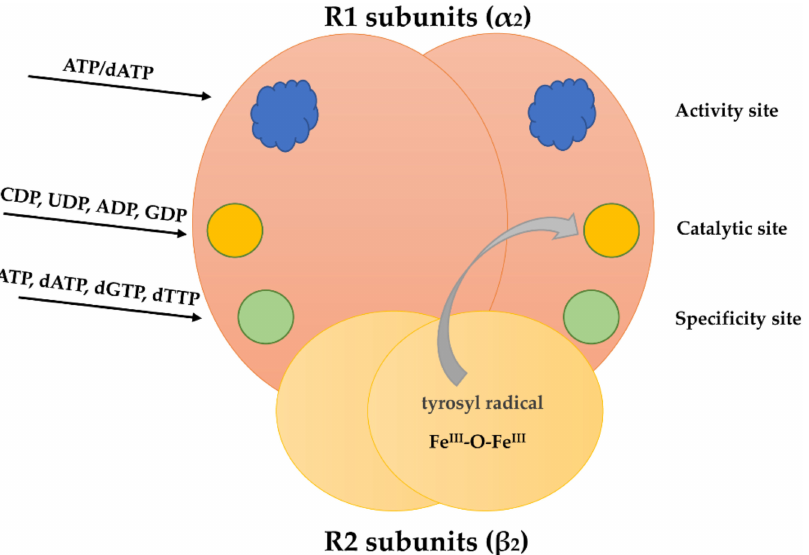
Figure 2. Schematic figure of the RNR heterotetramer. Each R1 subunit has two allosteric (activity and specificity sites) and one substrate binding site (catalytic site). The R2 subunits have a metal-oxygen center with a tyrosyl radical. This radical can be transferred to the catalytic site.